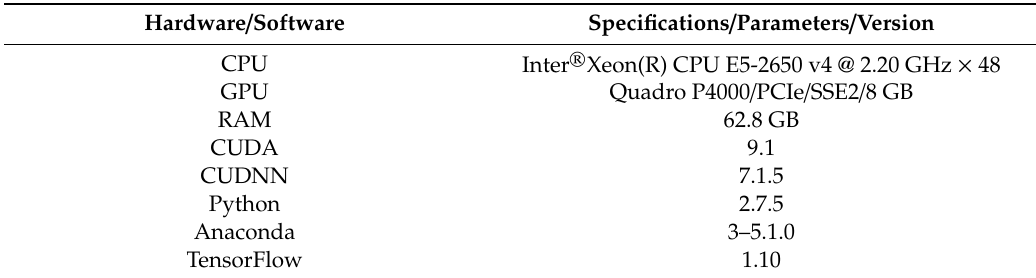
Table 2. Experimental software version and hardware